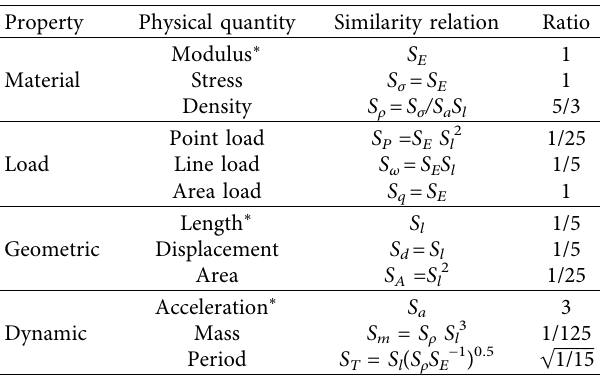
Table 2: Similitude parameters of the shaking table test for 8m piers.